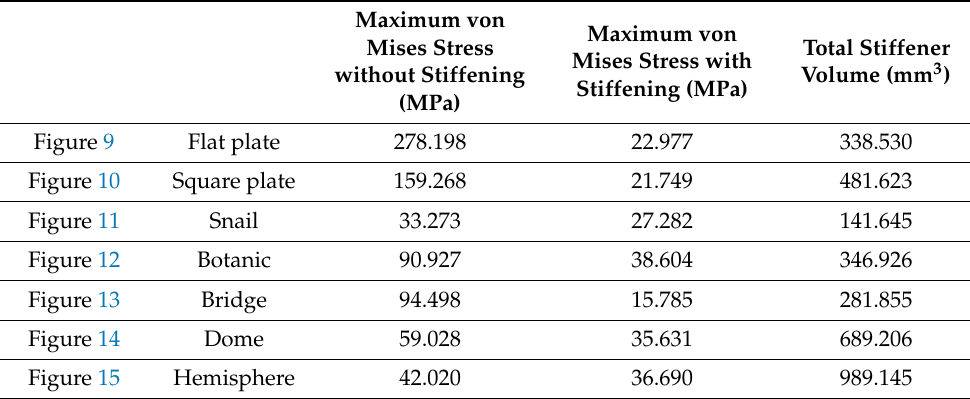
Table 3. Total stiffener volume and maximum von Mises stress in the shells with and without